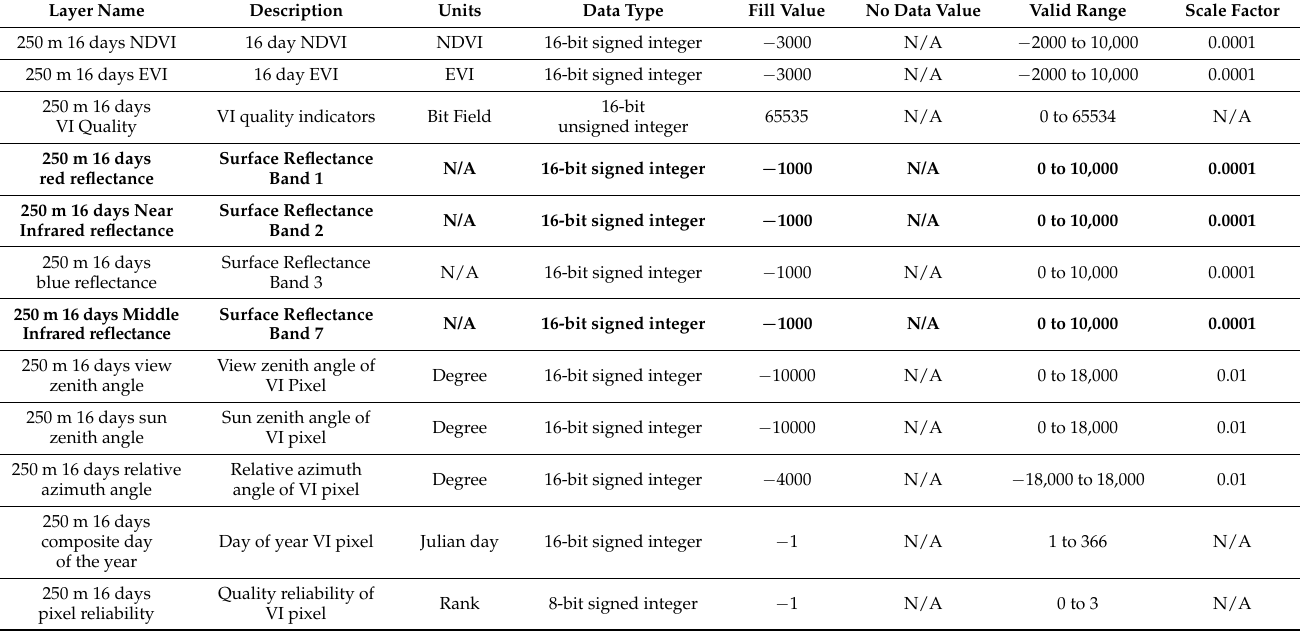
Table 3. Layers of MOD13Q1 product [59]; the bands used to calculate the Normalized Difference Drought Index (NDDI) (1, 2 and 7) are given in